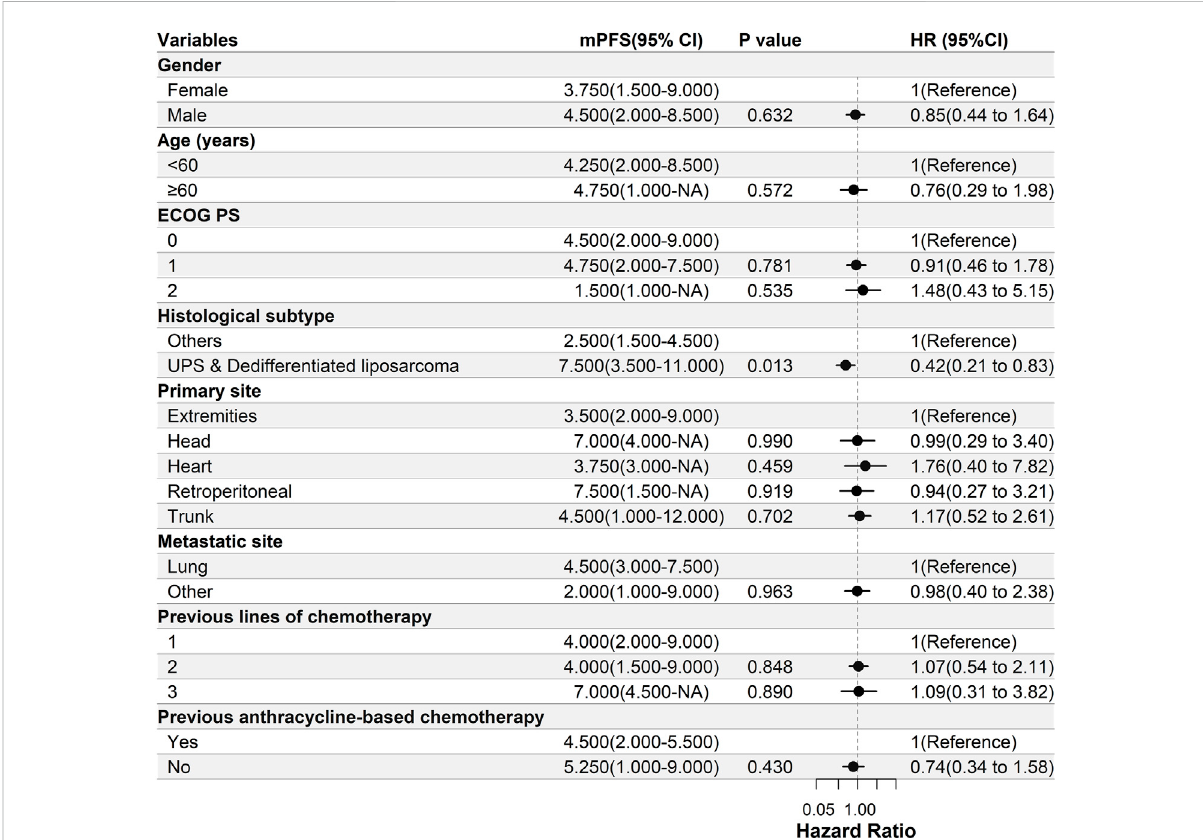
FIGURE 3 Univariate Cox regression analysis of the relationship between clinicopathological parameters and PFS. Patients with UPS or dedifferentiated liposarcomahavesigni fi cantlylonger PFSthanthosewithotherpathologicalsubtypes [hazardratio(HR)=0.42,95% CI0.21 – 0.83, p =0.013]. ECOG PS, Eastern Cooperative Oncology Group Performance Status; PFS, progression-free survival; UPS, undifferentiated pleomorphic sarcoma; DOX, doxorubicin; mPFS, median PFS; NA, not